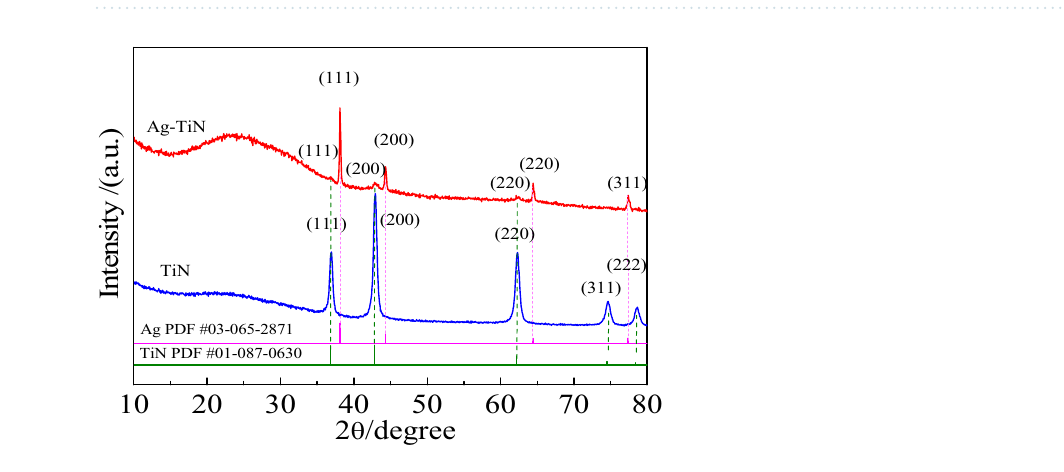
Figure 4. P-XRD patterns of TiN/SMS and